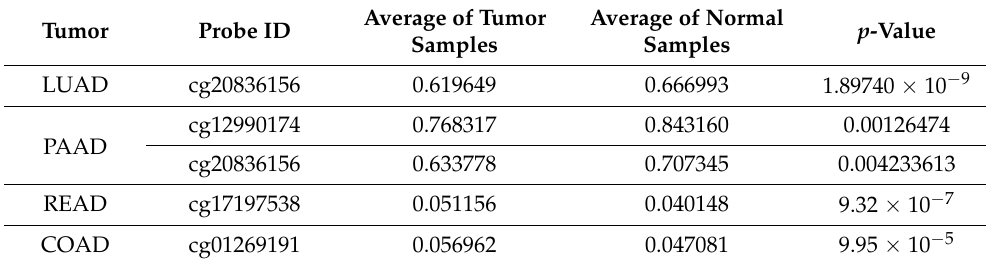
Table 3. Annotation information of DNA methylation